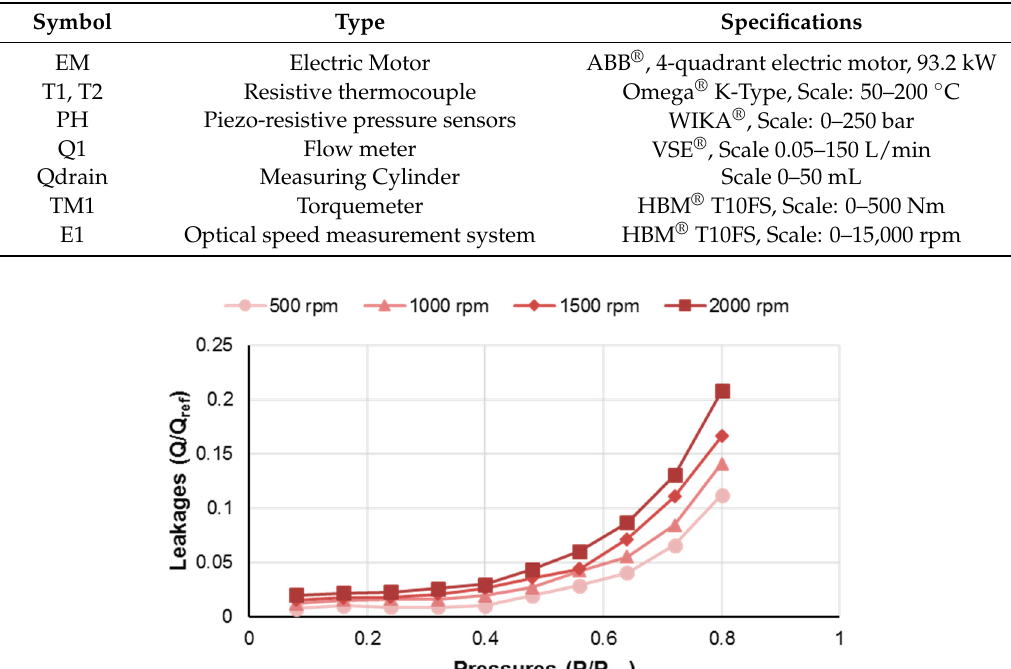
Figure 13. Comparison of measured drain leakages with the simulated ones from the full and mixed film models at an operating speed of 500 rpm.